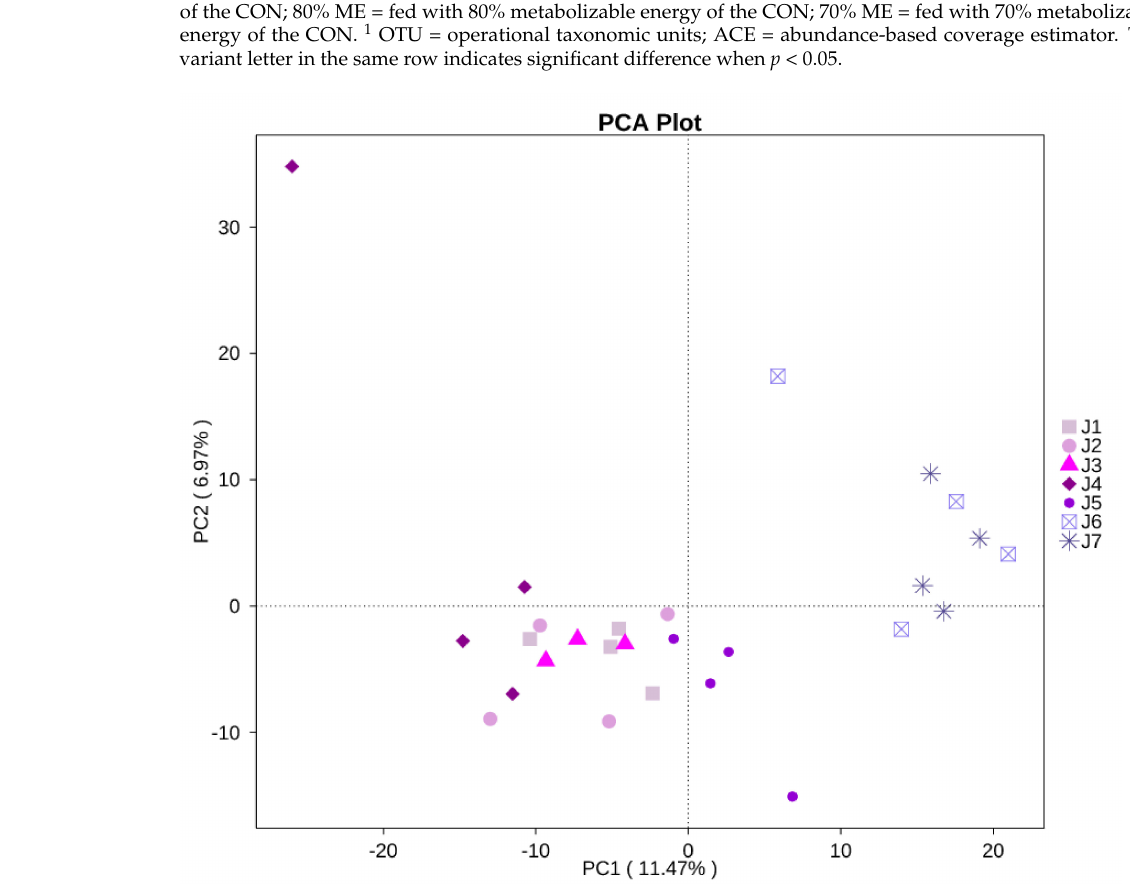
Figure 1. Principal component analysis (PCA) plot of the cecal microbiota. J1 = CON, fed with the basal diet ad libitum; J2 = 90% FI, fed with 90% feed intake of the CON; J3= 80% FI, fed with 80% feed intake of the CON; J4 = 70% FI, fed with 70% feed intake of the CON; J5 = 90% ME, fed with 90% metabolizable energy of the CON; J6 = 80% ME, fed with 80% metabolizable energy of the CON; J7 = 70% ME, fed with 70% metabolizable energy of the